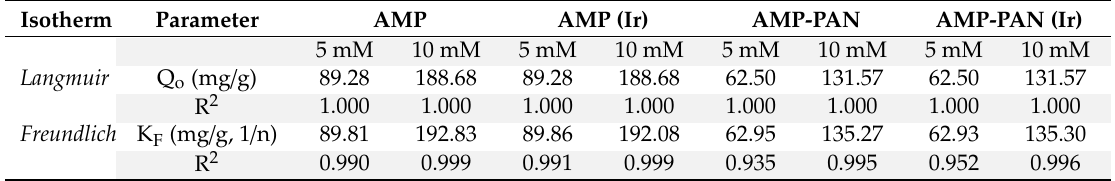
Table 1. Comparison of calculated Langmuir and Freundlich isothermal